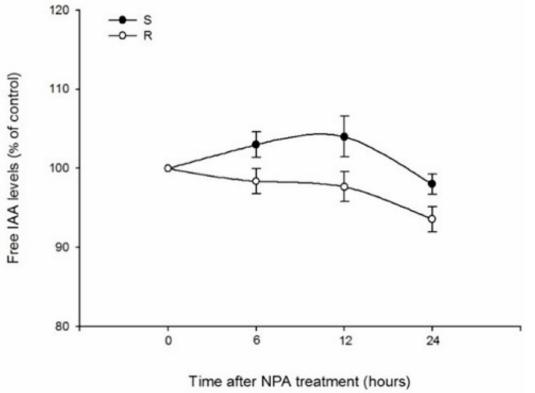
Figure 6. IAA contents in upper root tissues were measured in S (susceptible, JNNX-S) and R biotypes (resistant, SSXB-R) after treatment with 1-N-naphthylthalamic acid (NPA) (100 µ M) at 0 h, 6 h, 12 h and 24 h. Data are the mean values of at least three biological replicates. The standard errors of the means are described by vertical